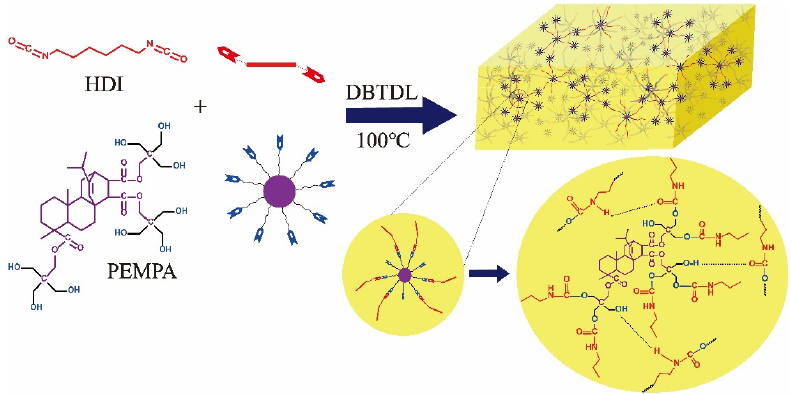
Figure 1. Synthesis of the VPU OH cross-linking